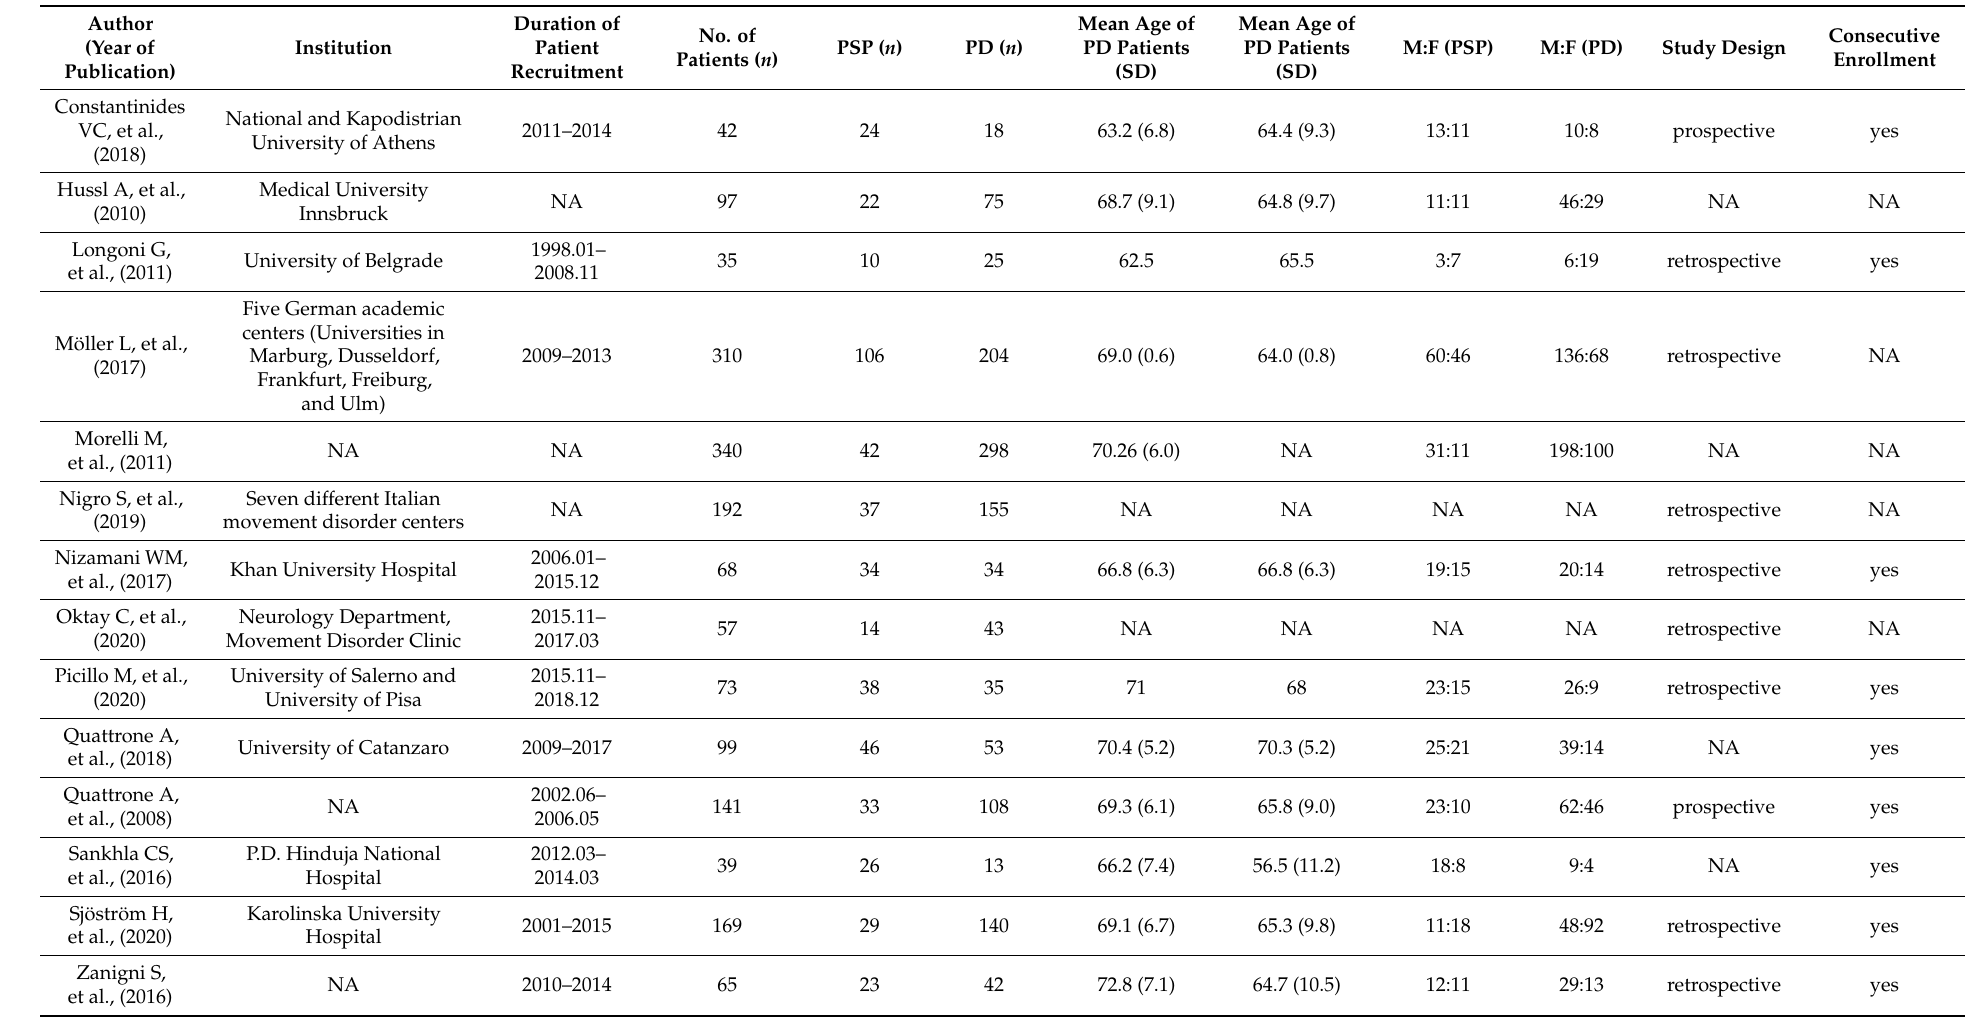
Table 1. Study and patient characteristics of the selected